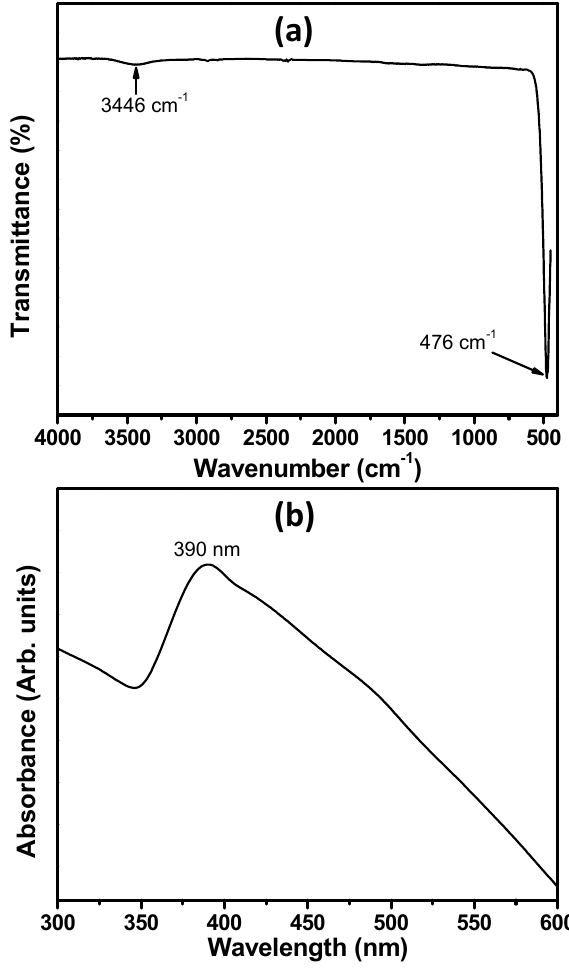
Figure 3. ( a ) FTIR; and ( b ) UV-Vis. spectra for hydrothermally synthesized ZnO nanoballs.